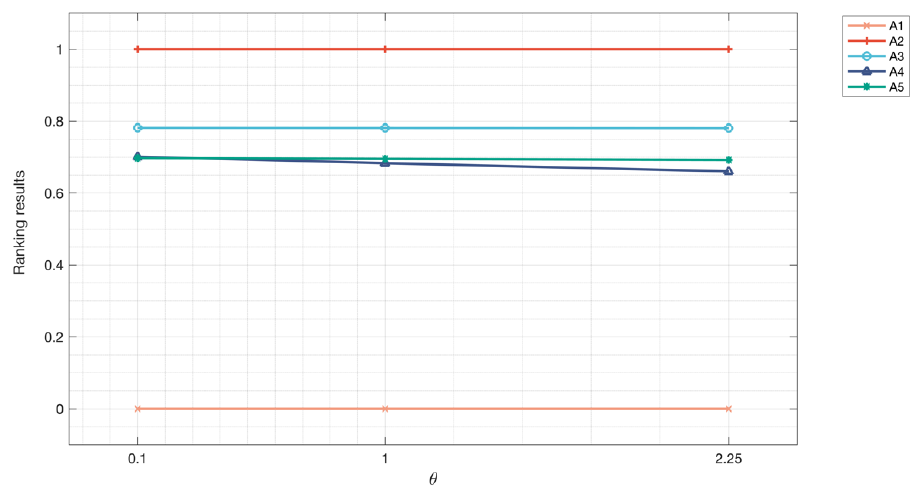
Figure 9. Results of theta sensitivity analysis for the same risk preferences of stakeholders.